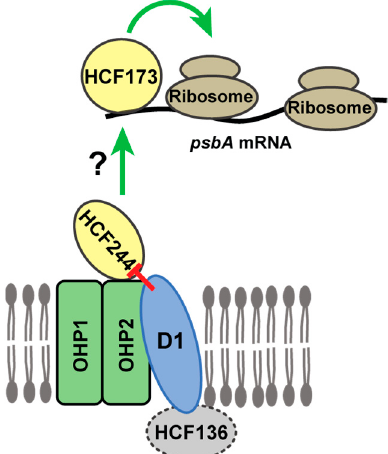
Figure 6. Model for negative autoregulation of psbA translation initiation in the context of the HCF244/OHP1/OHP2 complex. OHP1 and OHP2 are integral thylakoid proteins, and HCF244 is tethered to OHP2 on the stromal face of the membrane [13,14,16,17] . HCF173 binds the 5 ′ -UTR of psbA mRNA and is required for psbA translation initiation [23,32,34]. We propose that stroma-exposed features of the complex (HCF244 and / or OHP2’s stromal tail) collaborate with HCF173 to activate psbA translation initiation, and that the presence of D1 in the complex inhibits communication to HCF173. This is a simplified cartoon that does not incorporate evidence that other PSII core subunits (PsbI, D2, PsbE, PsbF) also associate with the HCF244 / Ycf39 complex under some conditions [13,14,17]. Ycf48 (the HCF136 homolog in cyanobacteria) associates with this complex when downstream steps in PSII assembly are disrupted, but there is conflicting evidence about the association of HCF136 with the HCF244 complex in plants [13,14,17] .